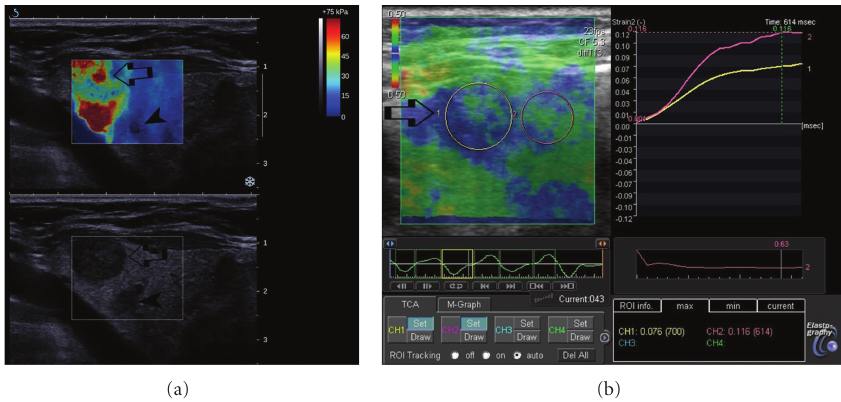
Figure 1: Di ff use sclerosing papillary carcinoma of the left lobe of the thyroid gland (arrow) in patient with multinodular goiter and multiple colloid nodules (arrow head). (a) on B-mode ultrasound (lower image), the cancer is less suspicious than some of the colloid nodules; however, on supersonic shear wave elastography (upper image) the nodule presents areas of high sti ff ness (over 75 kPa) indicating malignant lesion. The colloid nodule presents as a lesion with low sti ff ness. (b) on strain elastography, the carcinoma qualitatively and quantitatively presents features of soft lesion falsely indicating benign nature of the lesion.